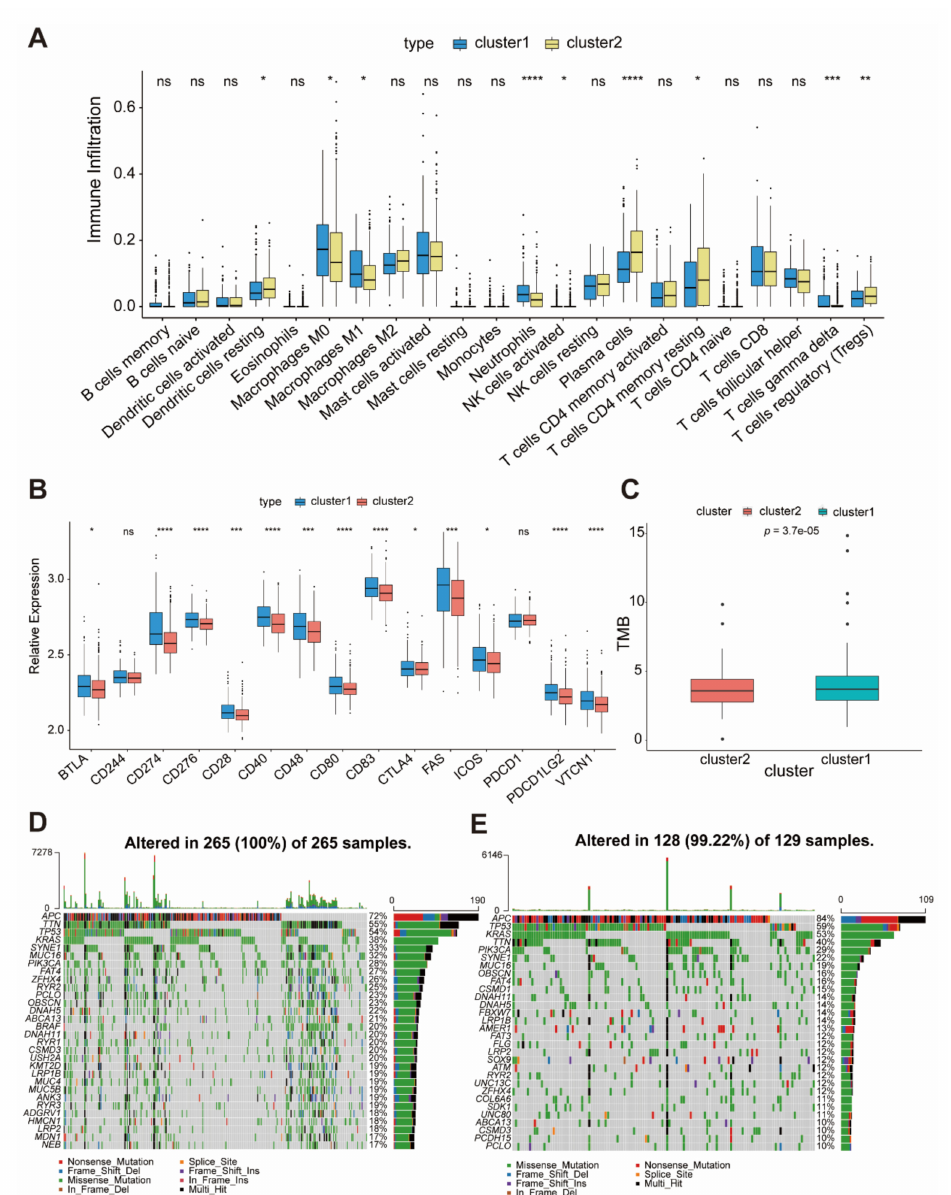
Figure 3. The characteristics of two molecular subgroups of colon cancer. ( A ) The abundance of each immune cell in two molecular subgroups of colon cancer. The upper and lower ends of the boxes represent the interquartile range of values. The lines in the boxes represent median value, and the black dots show outliers. The asterisks represent the statistical p value (* p < 0.05, ** p < 0.01, *** p < 0.001, **** p < 0.0001). ( B ) The expression of checkpoint genes in two clusters. The upper and lower ends of the boxes represent the interquartile range of values. The lines in the boxes represent median value, and the black dots show outliers. The asterisks represent the statistical p value (* p < 0.05, *** p < 0.001, **** p < 0.0001, ns means no significance). ( C ) Difference in TMB between cluster1 and cluster2. ( D , E ) The waterfall plot of tumor somatic mutation established by those with cluster1 ( D ) and those with cluster2 ( E ). Each column represents individual patients. The upper bar plot shows TMB. The number on the right indicates the mutation frequency in each gene. The right bar plot shows the proportion of each variant